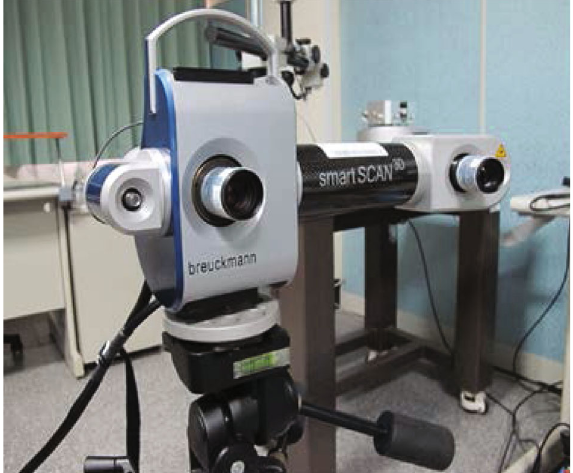
Figure 2: Breuckmann SmartSCAN 3D